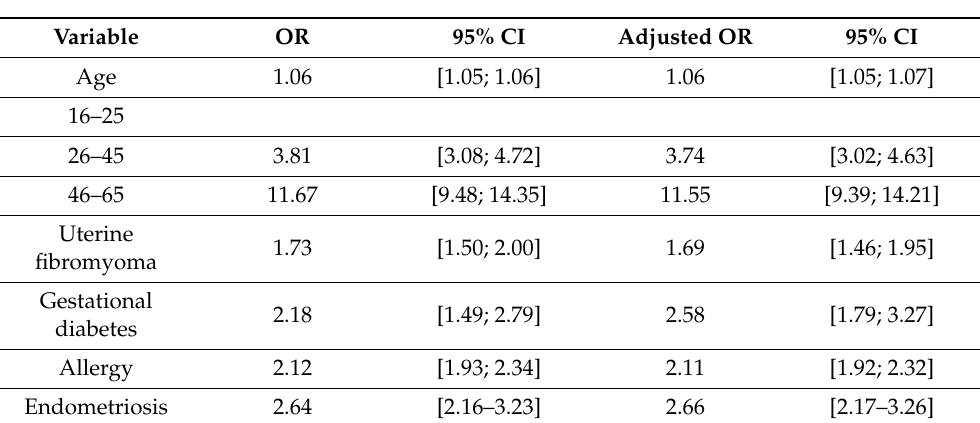
Table 5. Multivariate logistic regression